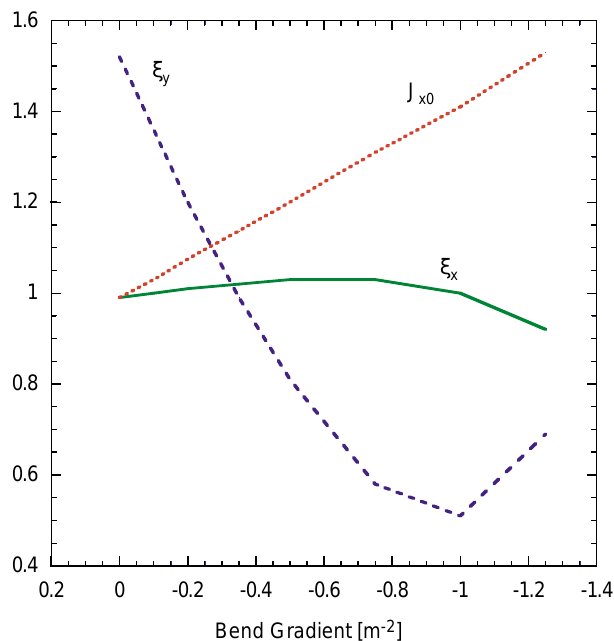
FIG. 9. (Color) Horizontal and vertical chromaticities and hori- zontal damping partition J x 0 versus the gradient in the bending magnet of the 6 m NLC MDR cell.